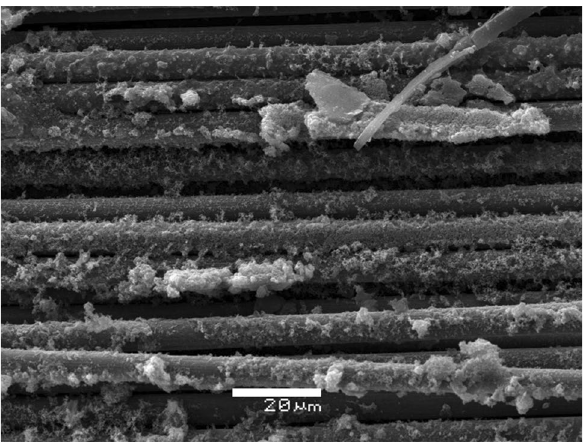
Figure 8. SEM images of the CFR-500 °C-CNTs specimens showing no adhesion to the matrix.